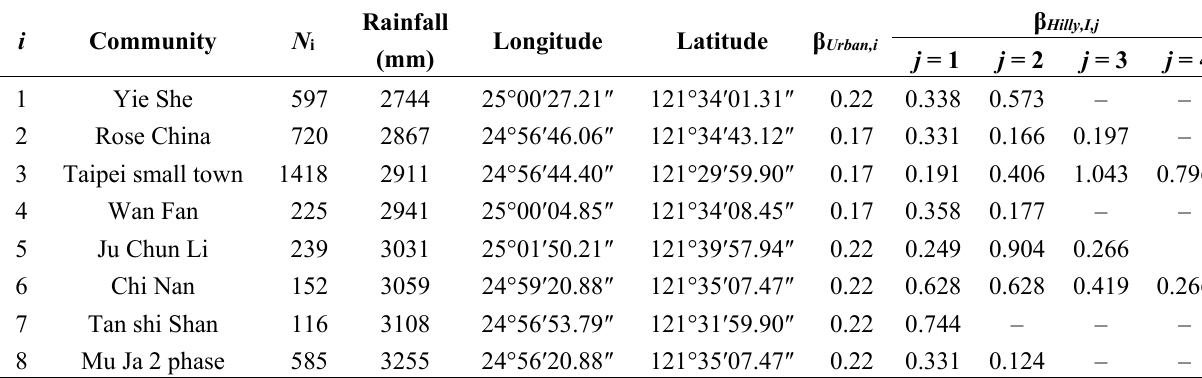
Table 1. Details of hilly communities with pumping stations managed by